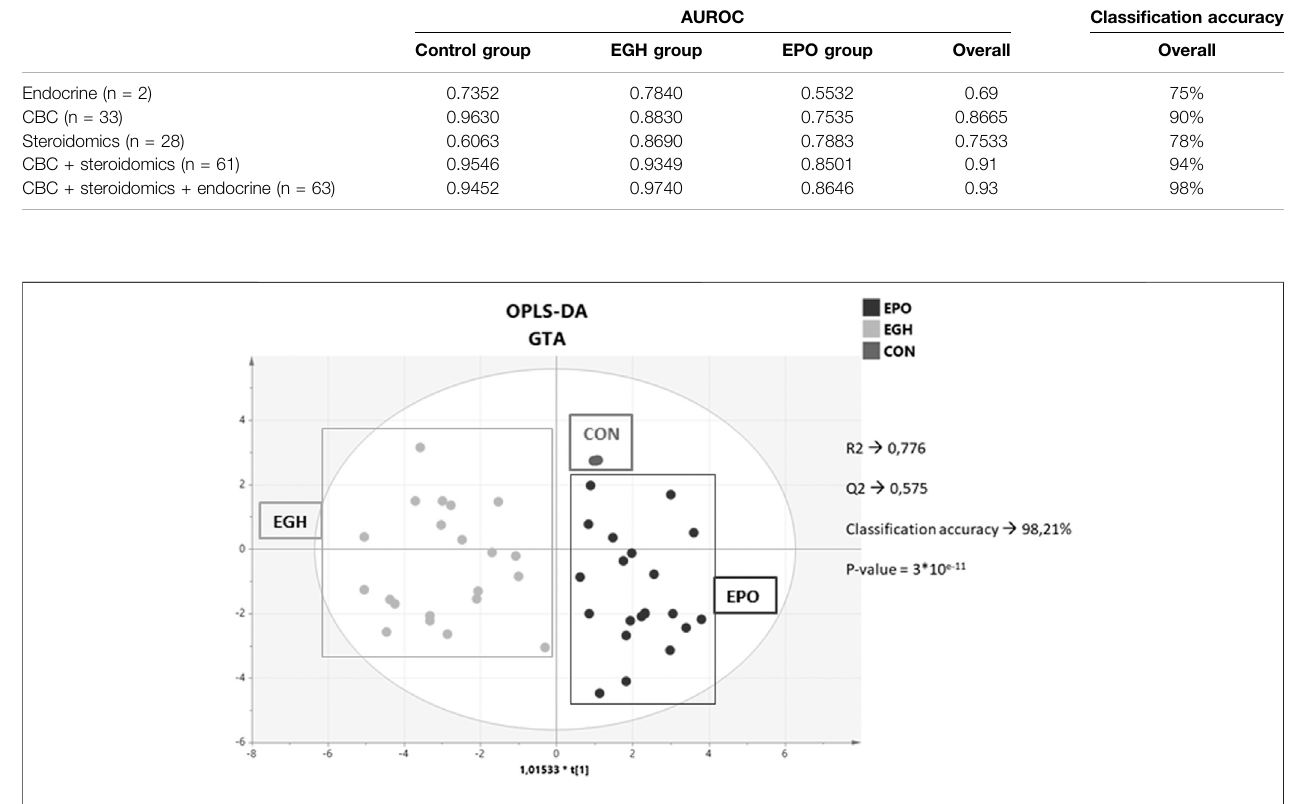
FIGURE 3 | Score plot of the OPLS-DA model on the combined dataset with the hematopoietic, steroidomics and endocrine